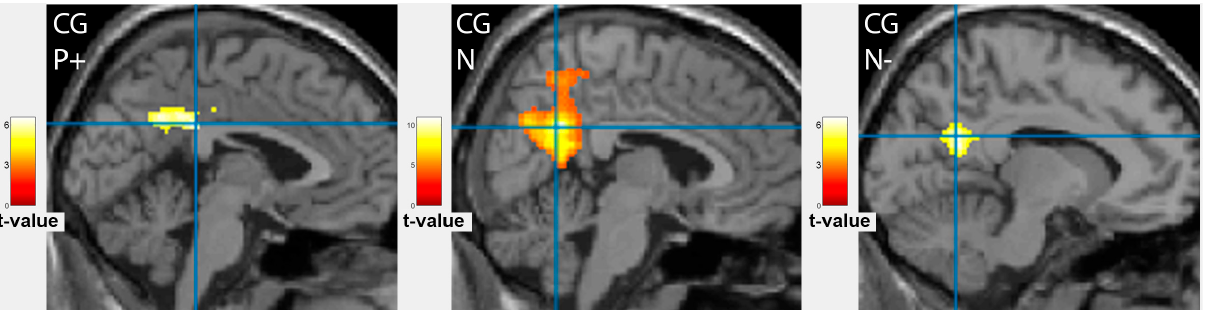
Figure 6. Deactivation zones in the cingulate cortex in the control group (CG), on the left, while processing negative (N ‐ ) and positive (P+) emotional information, and on the right, on demonstra ‐ tion of neutral faces (N).